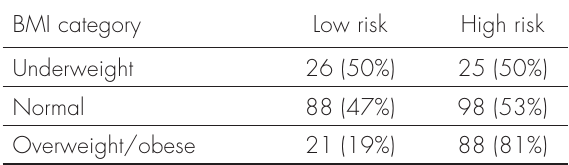
Table V. Association between BMI and risk category.